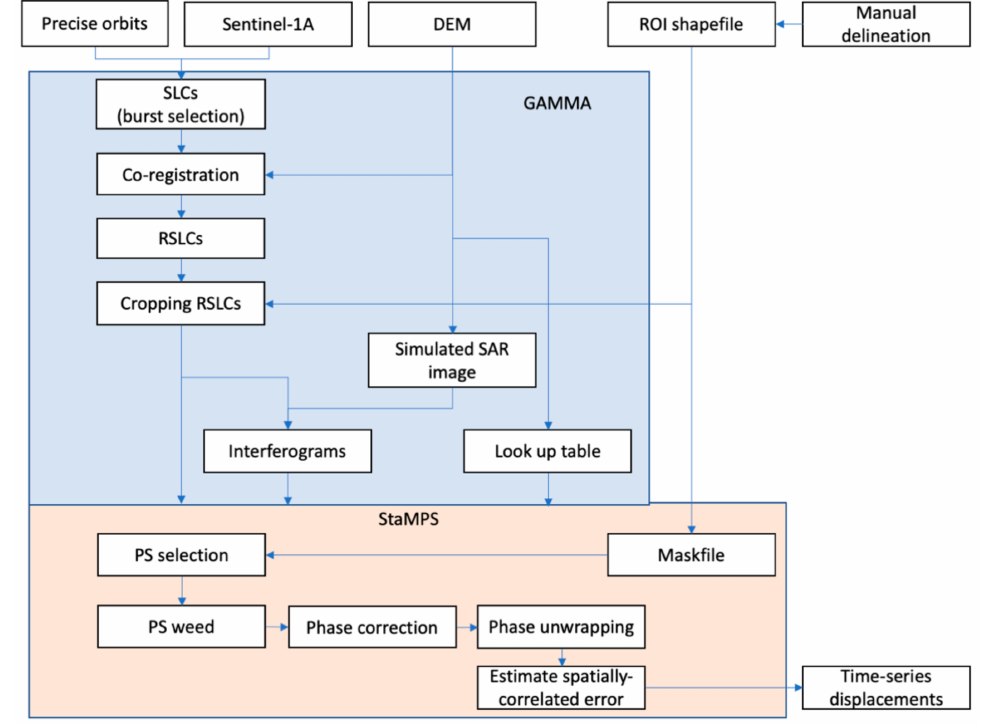
Figure 2. The processing flow of a persistent scatter-interferometric synthetic aperture radar